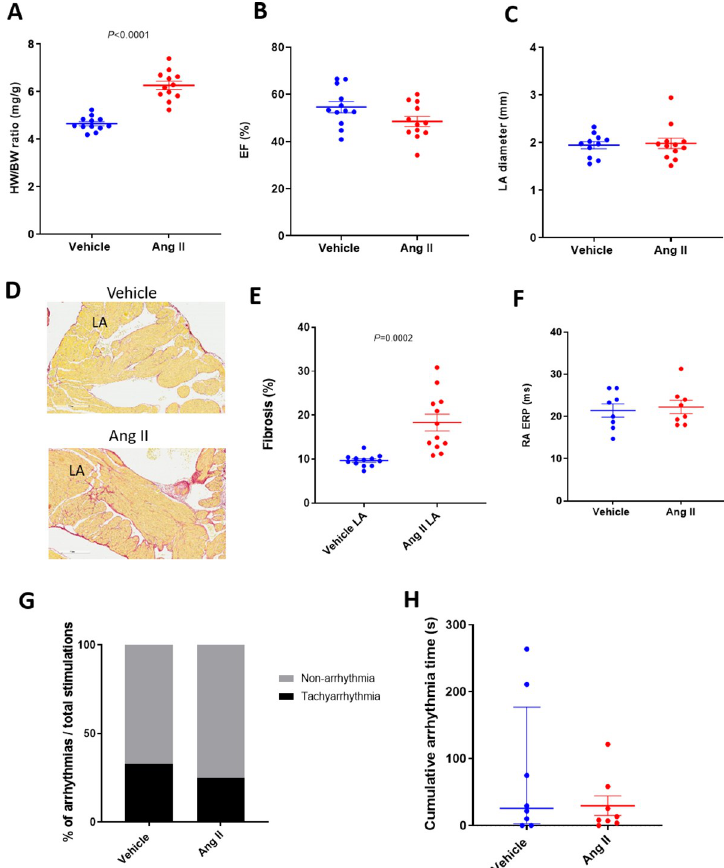
Fig 3. Heart phenotypes and burst pacing-induced tachyarrhythmia in Ang II mice. A: Heart weight / body weight ratio in vehicle and Ang II infusion mice (n = 12/group). Echocardiographic evaluation of EF (B) and LA diameter (C) in vehicle and Ang II infusion mice (n = 12/group). D: Representative images of fibrosis staining of the vehicle and Ang II infusion mouse atria. E: LA fibrotic area in vehicle and Ang II infusion mice (n = 8/group). F: RA ERP in vehicle and Ang II infusion mice (n = 8/group). Each point indicates individual animal data, and lines represent mean ± SEM. G: % of positive atrial tachyarrhythmias from total burst pacing stimulations in vehicle- and Ang II- treated groups. H: Cumulative atrial tachyarrhythmia time in vehicle and Ang II groups (n = 8/group). Each point indicates individual animal data, and lines represent median ±